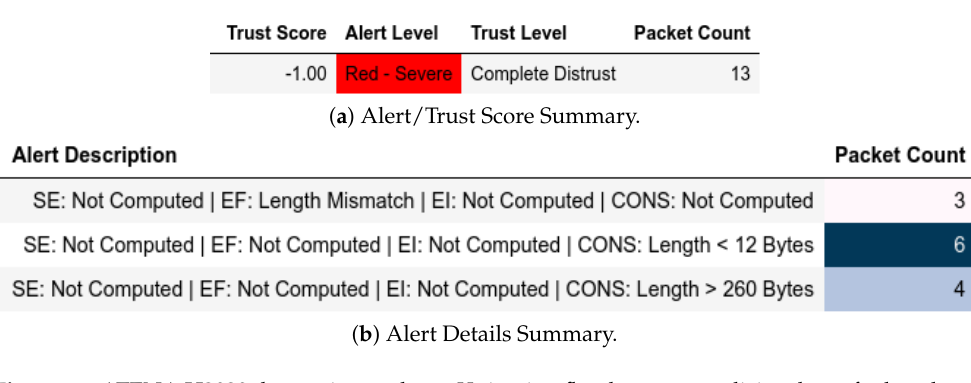
Figure 29. ATENA H2020 dataset internal test- H a in query flooding capture-query flooding of known query.